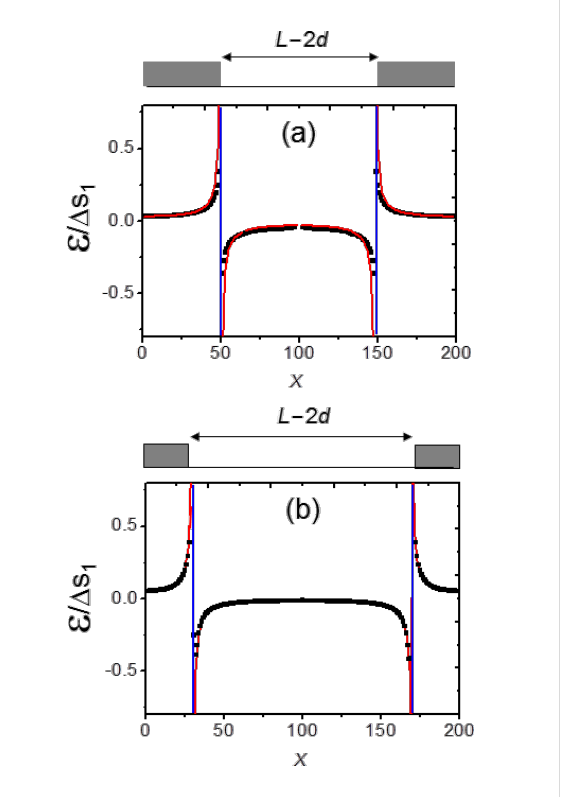
Figure 3: Normalised strain fields ε / Δ s 1 calculated for 1-D periodic stripes. (a) d / L = 1/2 , (b) d / L = 3/10. In both cases the continuous (red) curve corresponds to the classical solution of Equation 6 and black dots to the numerical solution of Equation 7. (Vertical blue lines corres- pond to the location of the ribbons edges sketched in grey in the upper part of the figures)